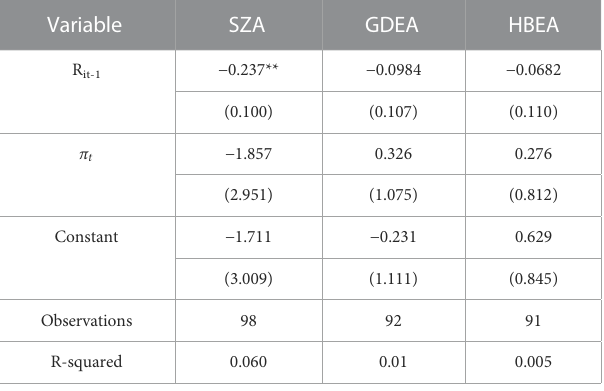
TABLE 2 Regression results of carbon price growth rate and in fl ation rate.